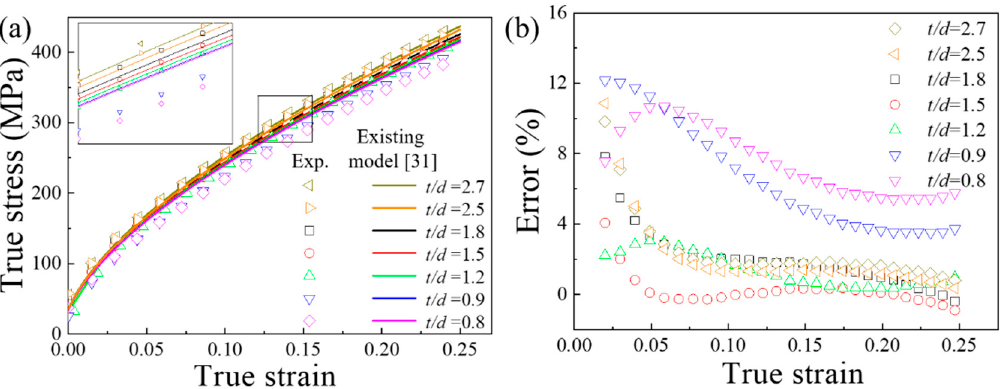
Figure 7. ( a ) Comparison of the experimental results and the prediction of the existing constitute model for true stress ‐ strain curves ( b ) Errors of existing models.